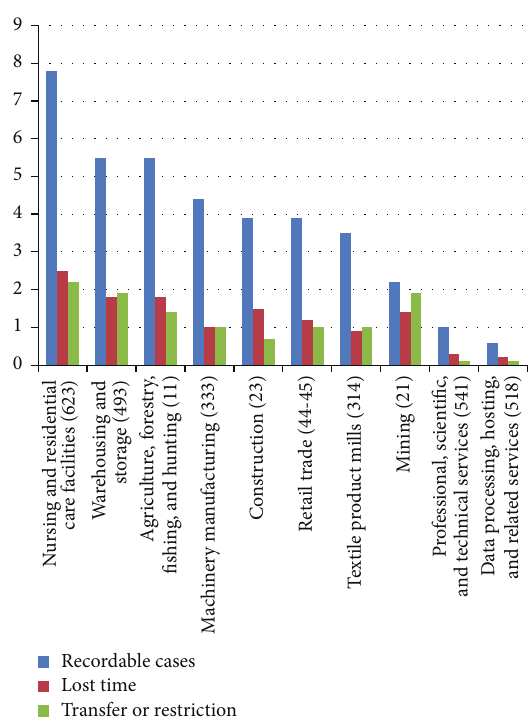
Figure 1: Work related injury by NAICS Sector, 2012, incidences per